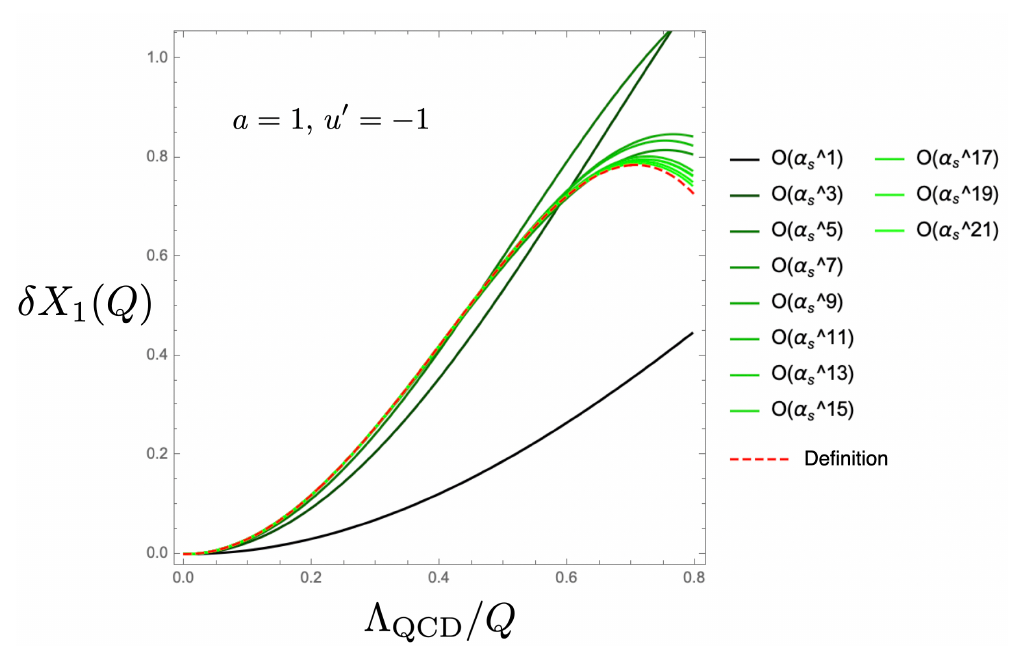
JHEP06(2022)157 ) s